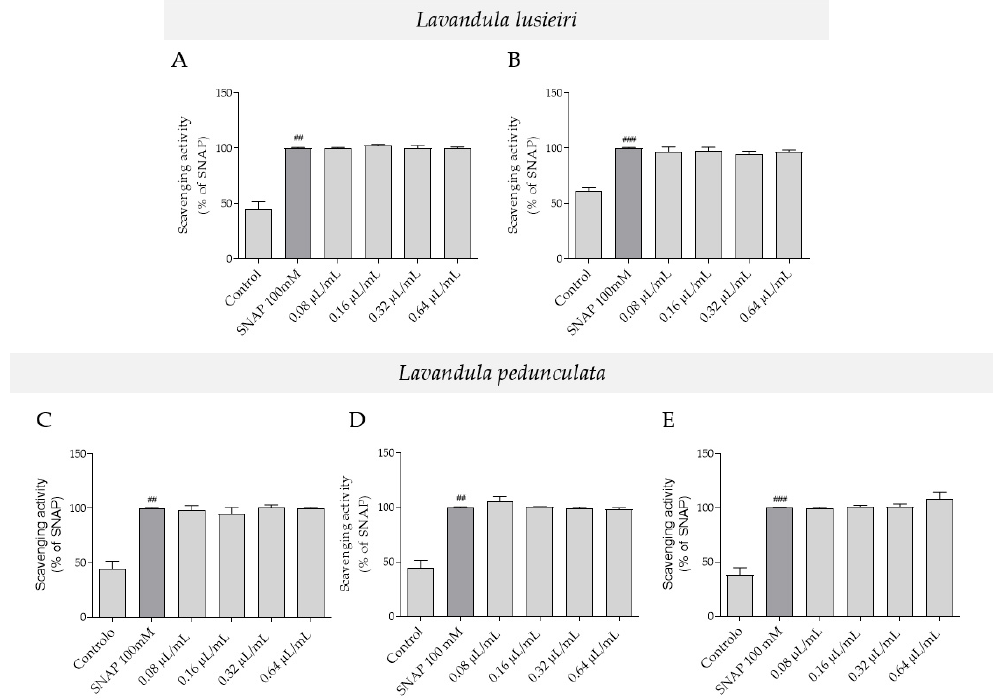
Figure 1. NO scavenging potential of Lavandula spp. essential oils. Effect of L. luisieri essential oil with ( A ) low (sample A1) or ( B ) high (sample A2) amounts of necrodane derivatives and L. pedunculata rich in ( C ) 1,8-cineole (sample B1), ( D ) fenchone (sample B2) and ( E ) camphor (sample B3). Differ- ent concentrations of essential oils (0.08–0.64 µ L/mL) were incubated with the NO donor, SNAP (100 mM), in culture medium for 3 h. Results are expressed as percentage of NO release triggered by SNAP (positive control, dark grey bars). Each value represents the mean ± SEM of three experiments, performed in duplicate (## p < 0.01, ### p < 0.001, compared to